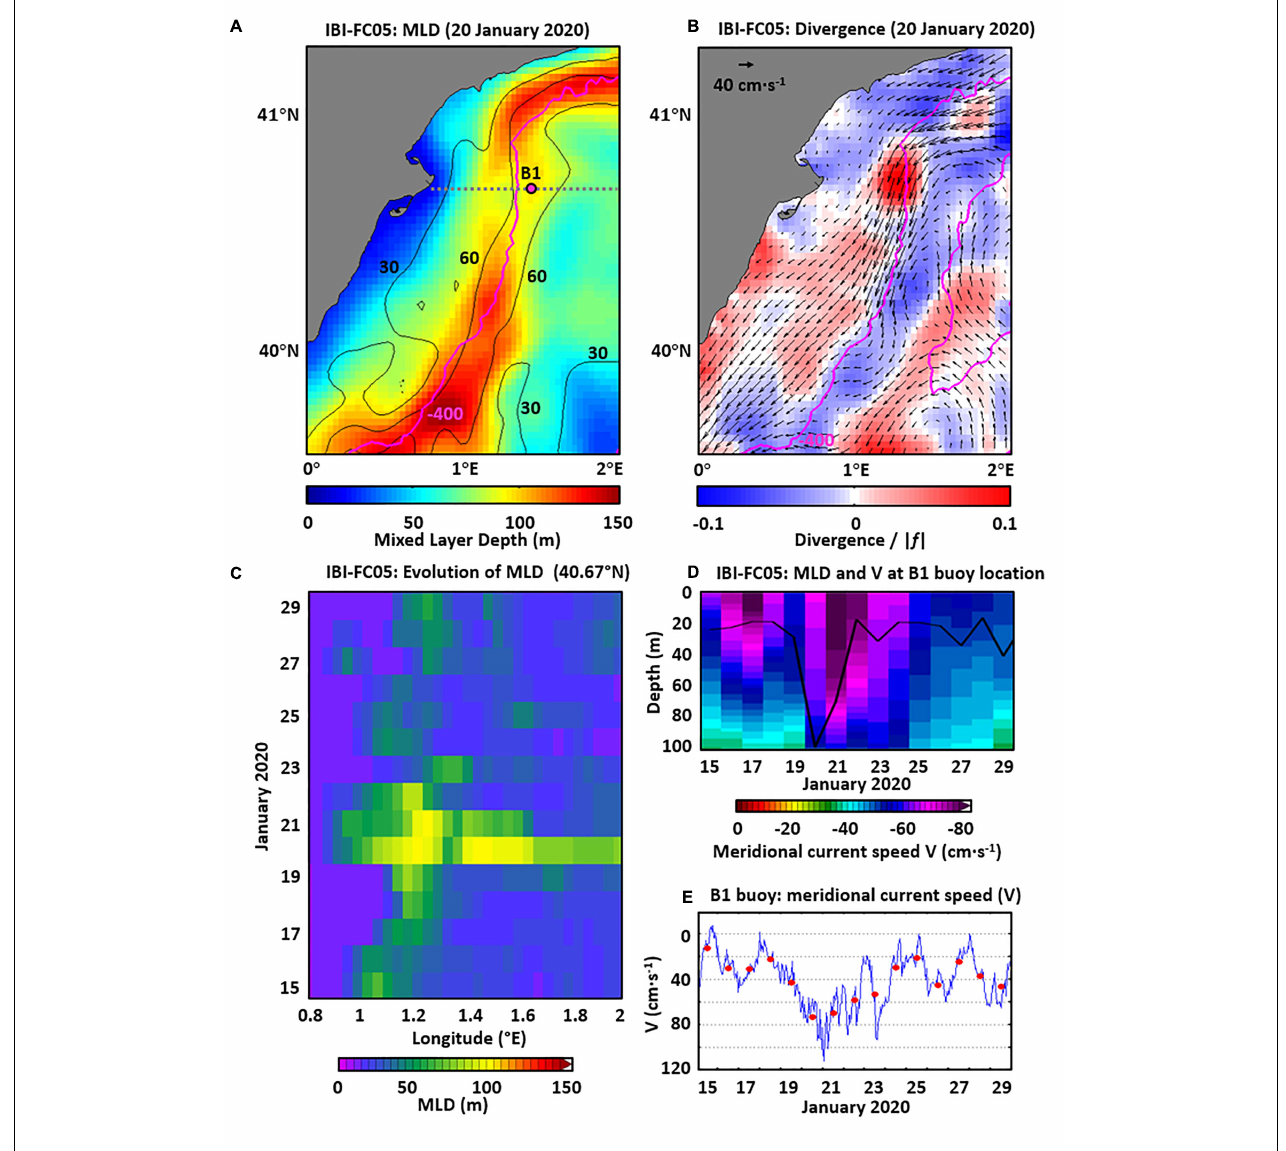
FIGURE 13 | (A) Map of mixed layer depth (MLD) for the January 20, 2020; contours indicate positive difference between MLD of January 20 versus January 18 (48 h before); (B) Map of daily averaged horizontal divergence as derived from IBI surface current outcomes five days ahead (IBI-FC05), for January 20; pink dot represents B1 buoy location; gray dotted line indicates transect of further analysis in panel (C) ; (C) Hovmöller diagram of daily MLD corresponding to a transect of constant latitude, denoted in panel (B) ; (D) Temporal evolution of MLD and meridional currents (V), derived from IBI-FC05 outcomes at B1 location: negative values of V indicate southward flow; (E) Time series of meridional (V) currents registered at B1 buoy: hourly and daily averaged values represented by a blue line and red filled dots,